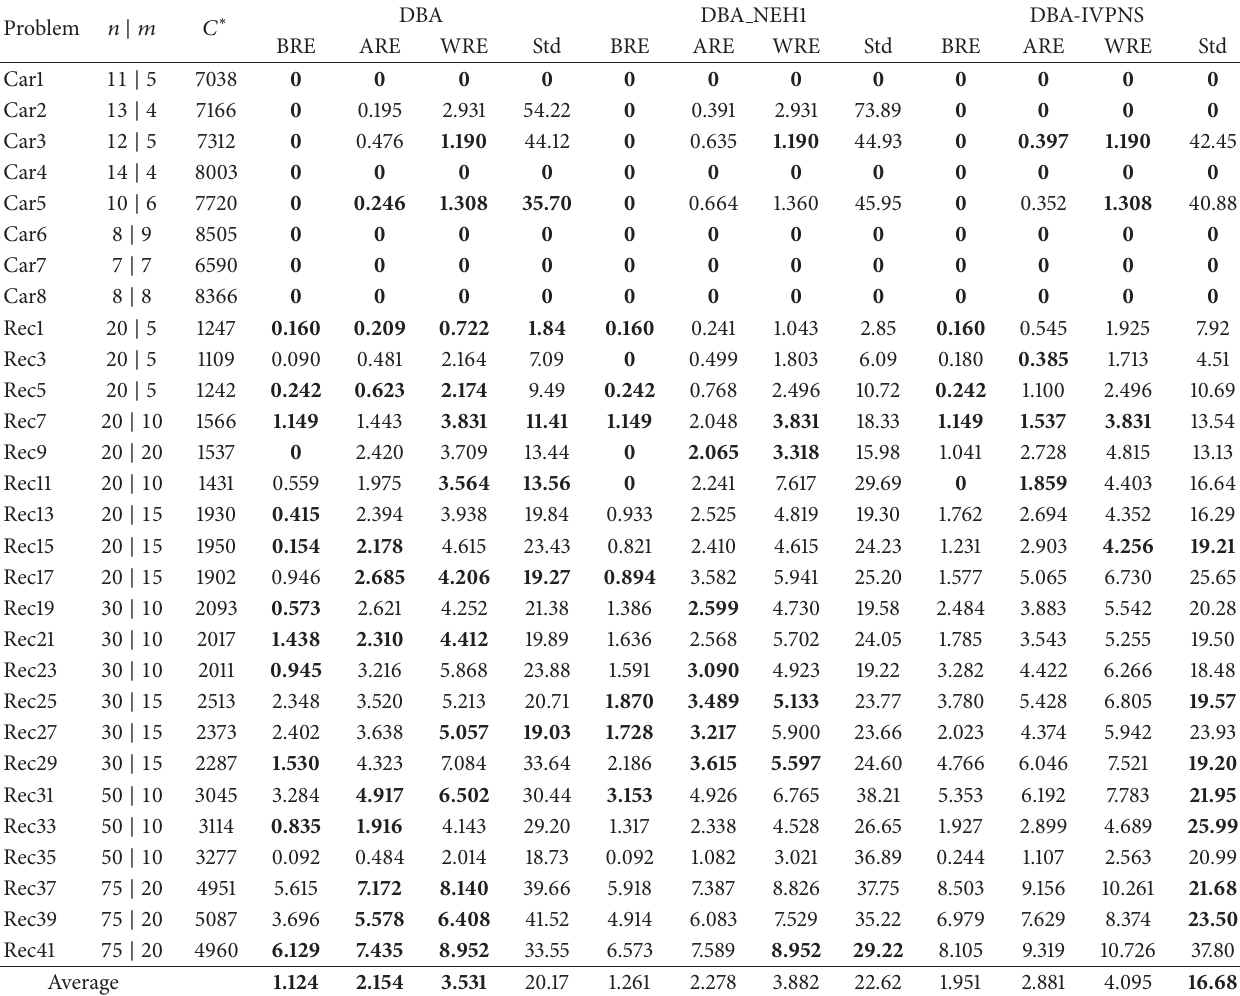
Table 1: Statistical performances of DBA, DBA NEH1, and